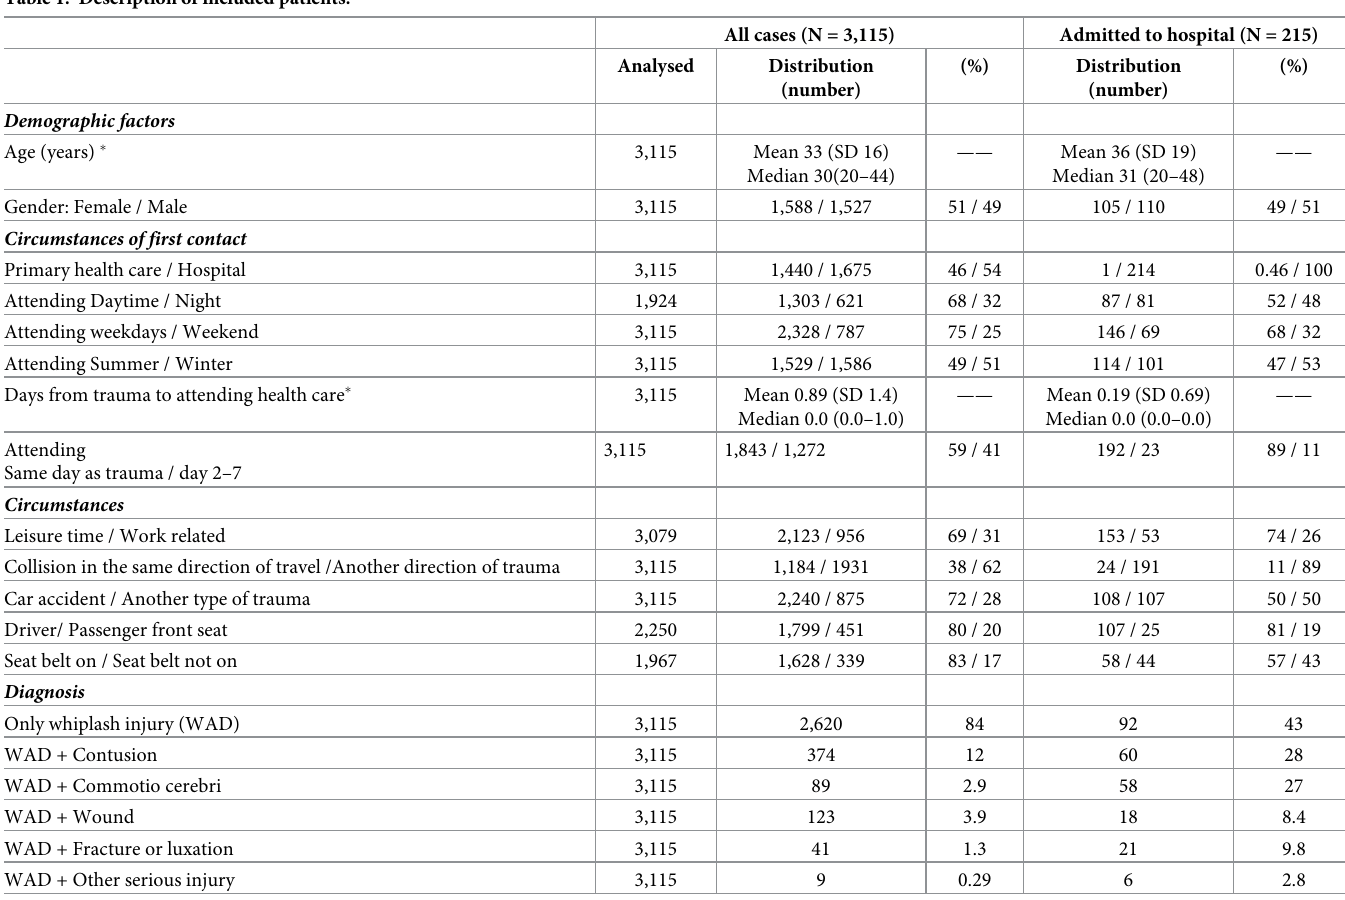
Table 1. Description of included